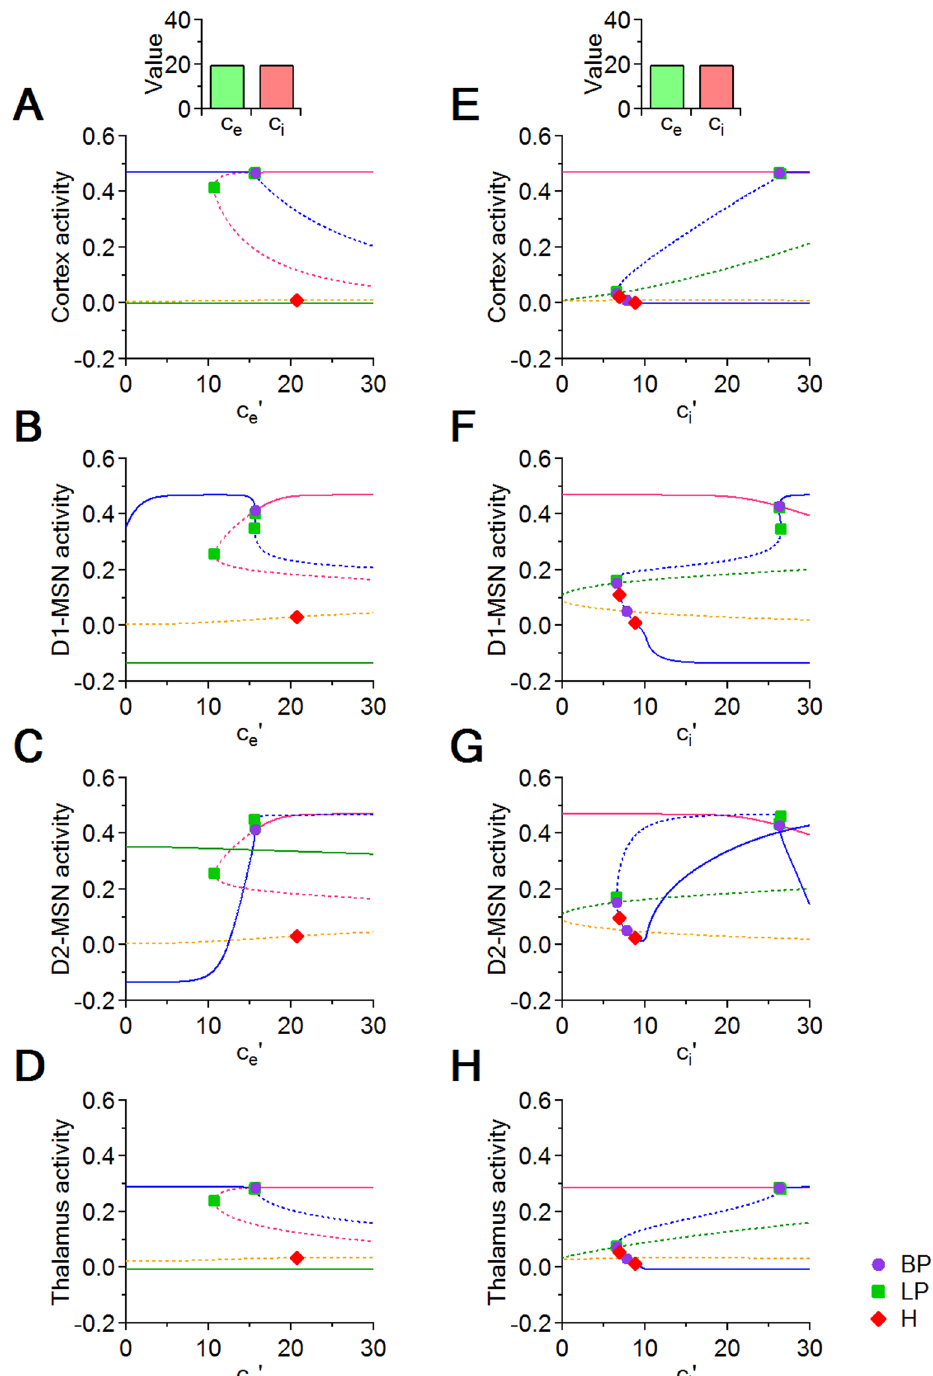
Figure 4. Bifurcation diagrams with respect to ′ c and ′ c . ( A – D ) In each panel, we test how changing the e i strength of local excitation onto D1- and D2-MSNs (i.e. ′ c ) affects the activity of the cortex, of the two e populations of MSNs and the thalamus. The strength of excitation and inhibition in the rest of the system is set to c e = c i = 20 (top inset). ( E – H ) In each panel, we analyze how changing the strength of inhibition onto D1- and D2-MSNs (i.e. ′ c ) affects the activity of the cortex, MSNs and the thalamus. The strength of excitation and i inhibition in the rest of the system is set to c e = c i =